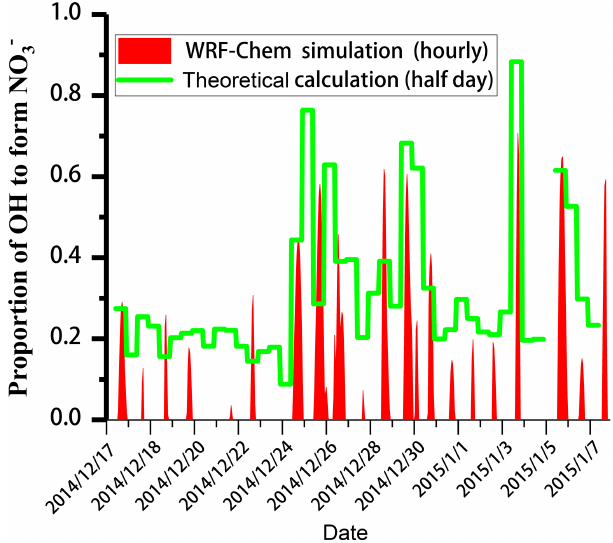
Figure 4. Comparison between the theoretical calculation and WRF-Chem simulation of the average contribution ratio ( γ ) for ni- trate formation in Nanjing via the reaction of NO 2 and photochem- (cid:113) ically produced